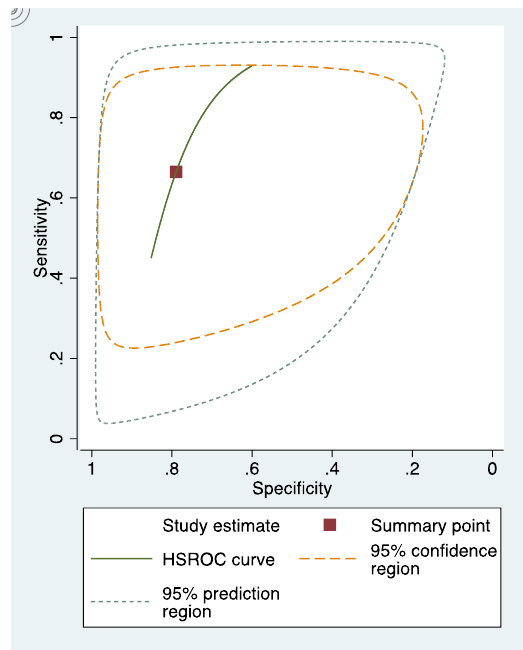
Figure 4. sRoc curves of photographic visual examination.